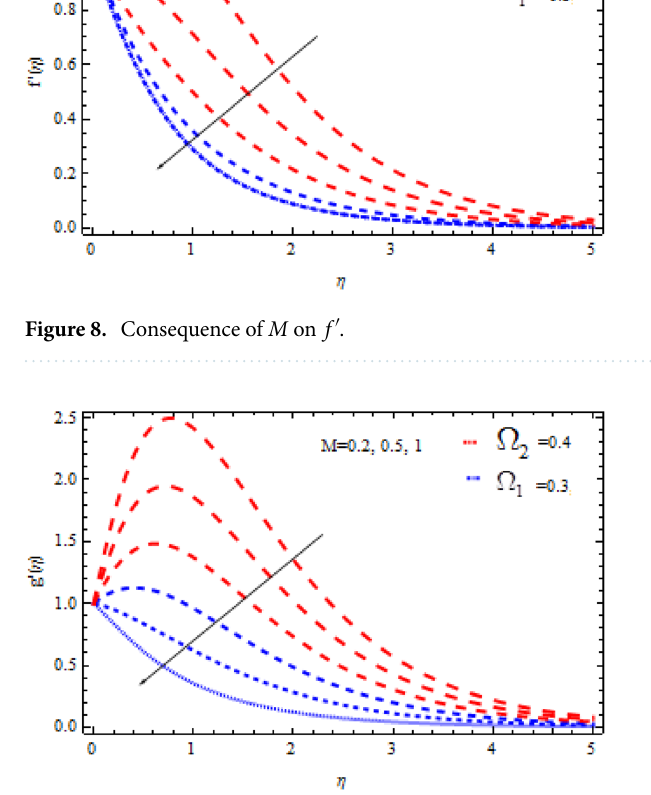
Figure 9. Consequence of M on g ′ .